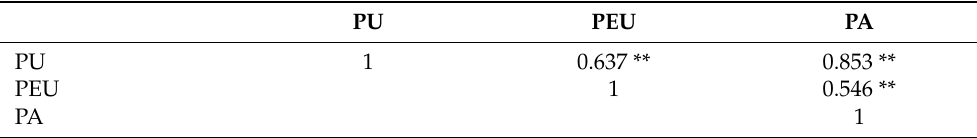
Table 4. Matrix of correlations between the variables of